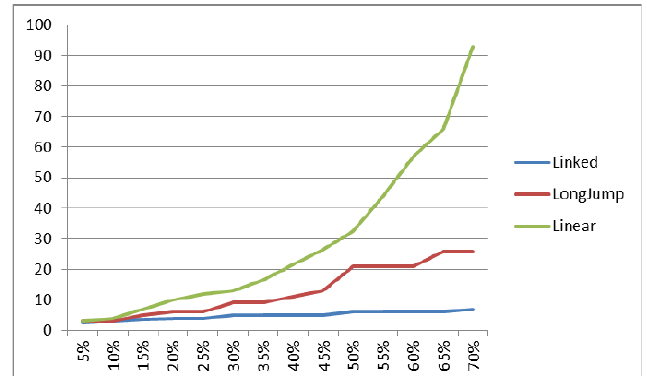
Fig. 6. Average max conflict for Murmur, size=786,433